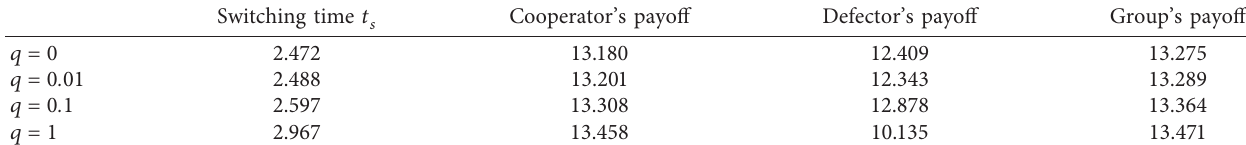
Table 3: Switching time and payoffs of individuals under